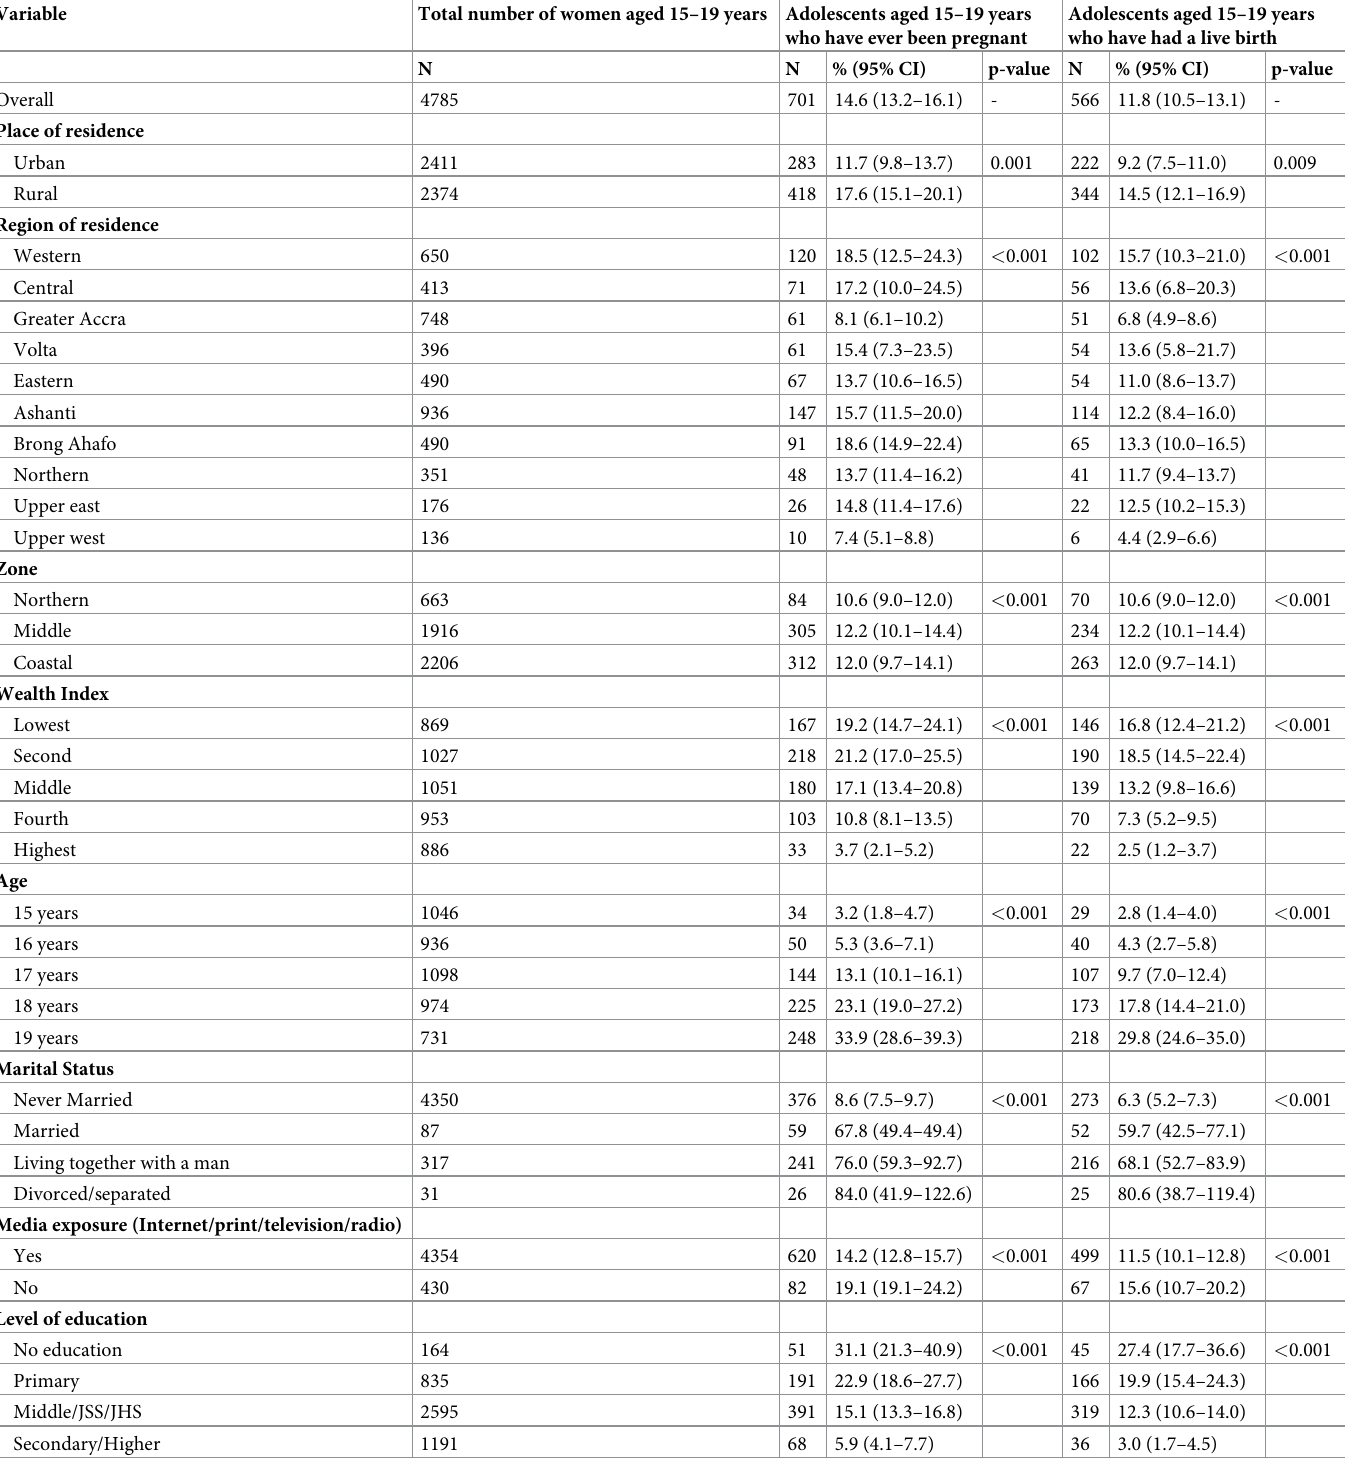
Table 3. Background characteristics of adolescents aged 15–19 years by pregnancy and birth